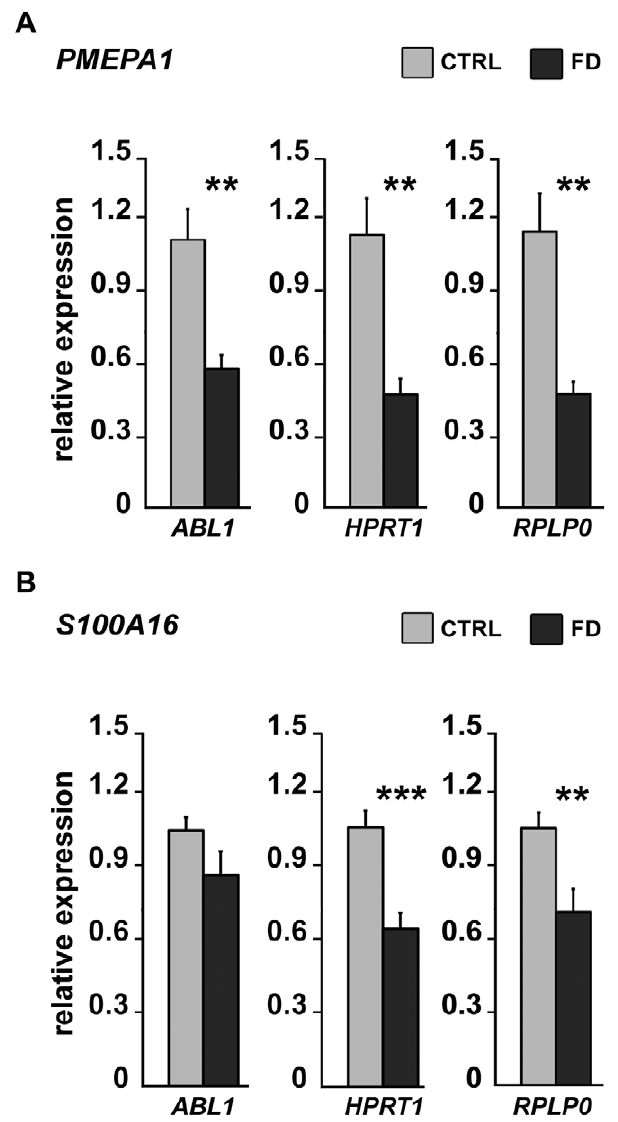
Figure 4. Relative levels of expression of PMEPA1 and S100A16 transcripts determined by RT-qPCR. RT-qPCR using total RNAs extracted from 4 controls and 4 FD hOE-MSCs at cell passages 2, 4 and 7. Histograms represent the mean value of PMEPA1 (A) and S100A16 (B) transcript expression level, relative to 3 reference genes ABL1 , HPRT1 , and RPLP0 in control (grey) and FD samples (black). Error bars denote standard errors. (* P , 0.05; ** P , 0,01, *** P , 0,001 using two-tailed Student’s test).